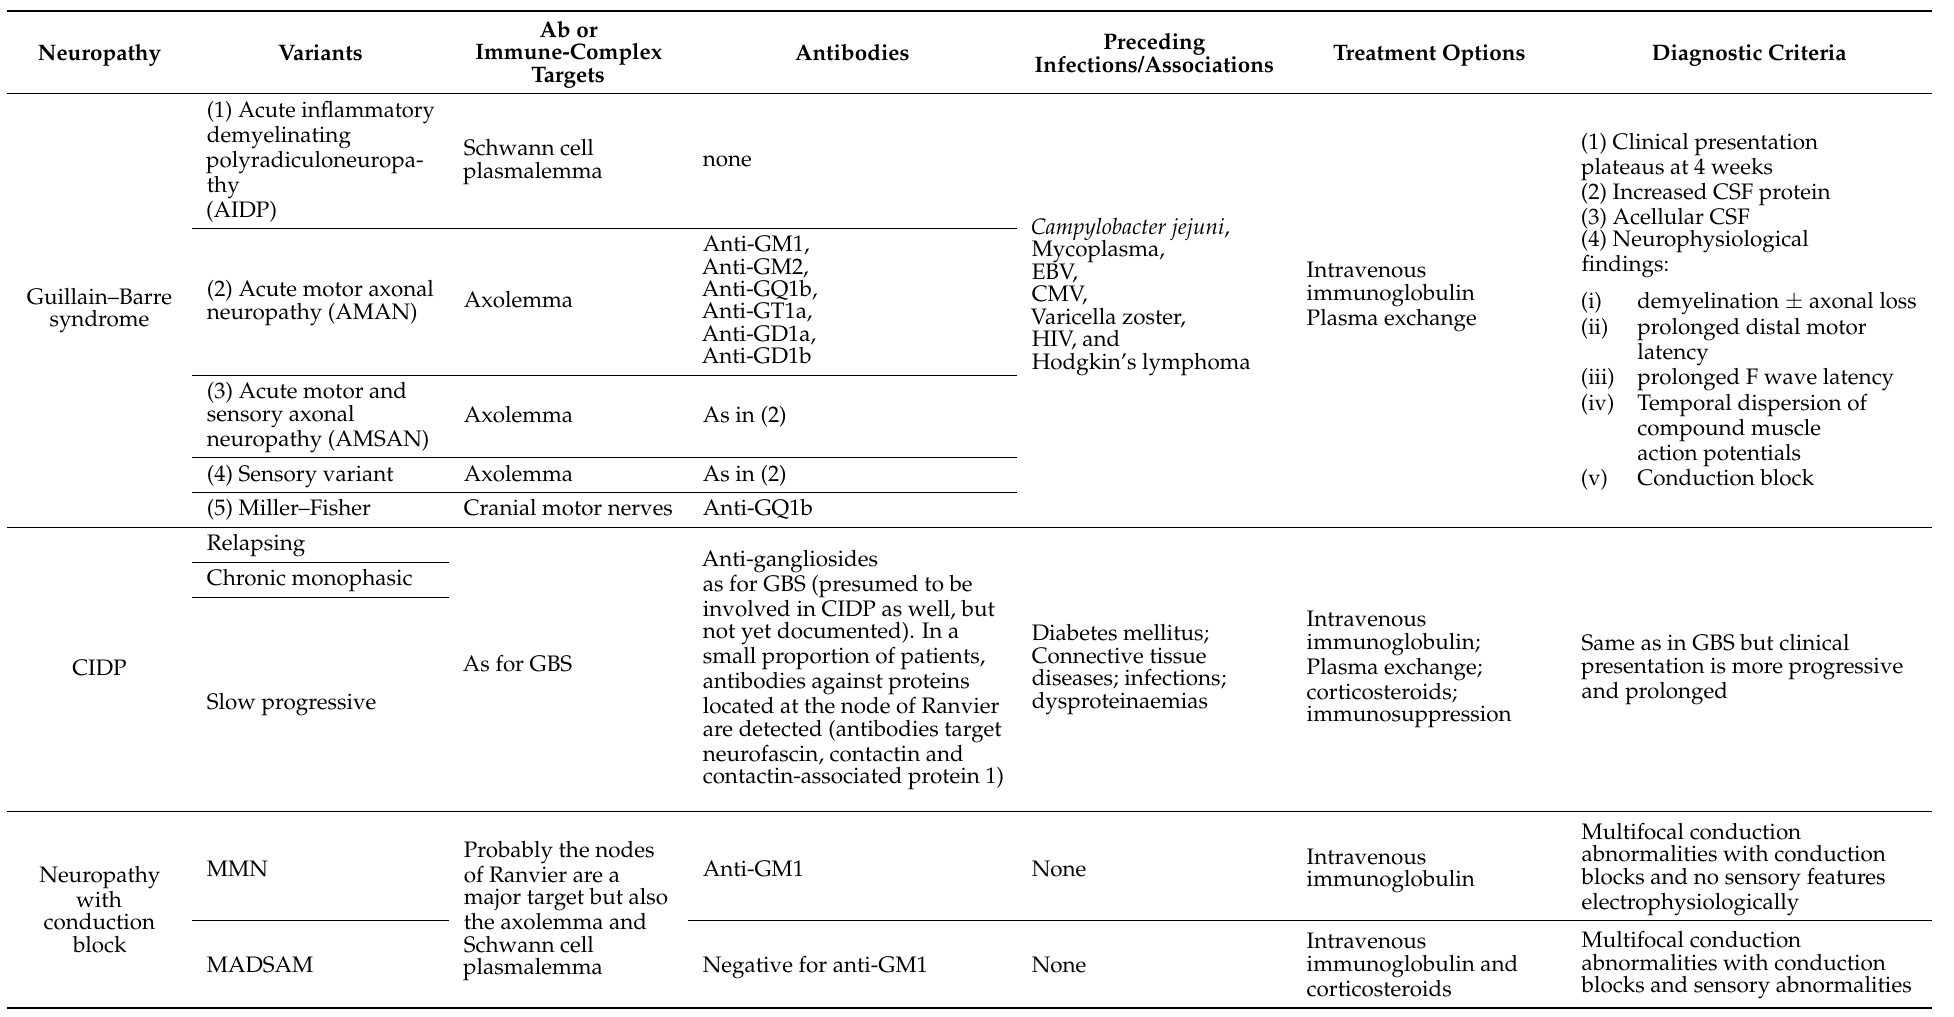
Table 1. Summary of the types of immune-mediated neuropathies and their key